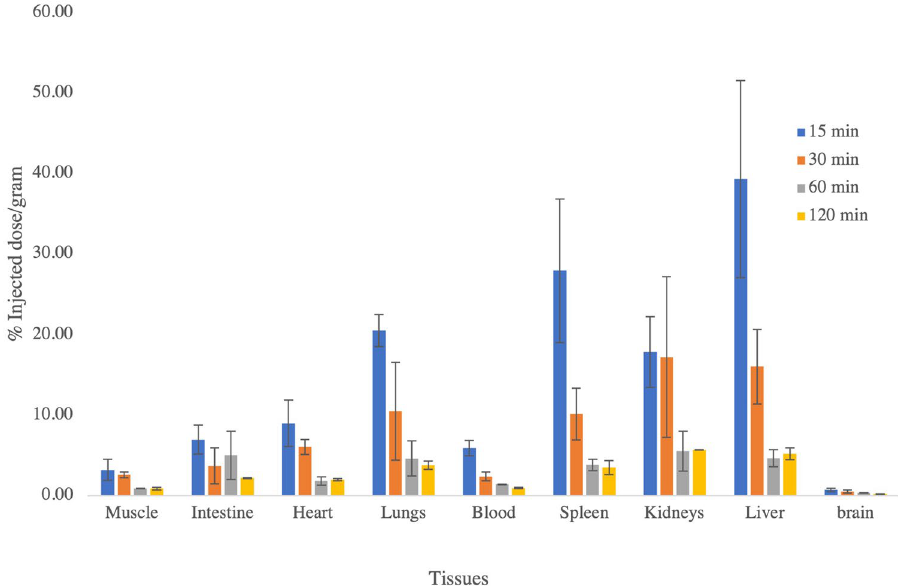
Figure 5. Diagram showing the distribution of [ 18 F]AVT-011 in mice and pattern changes with time.